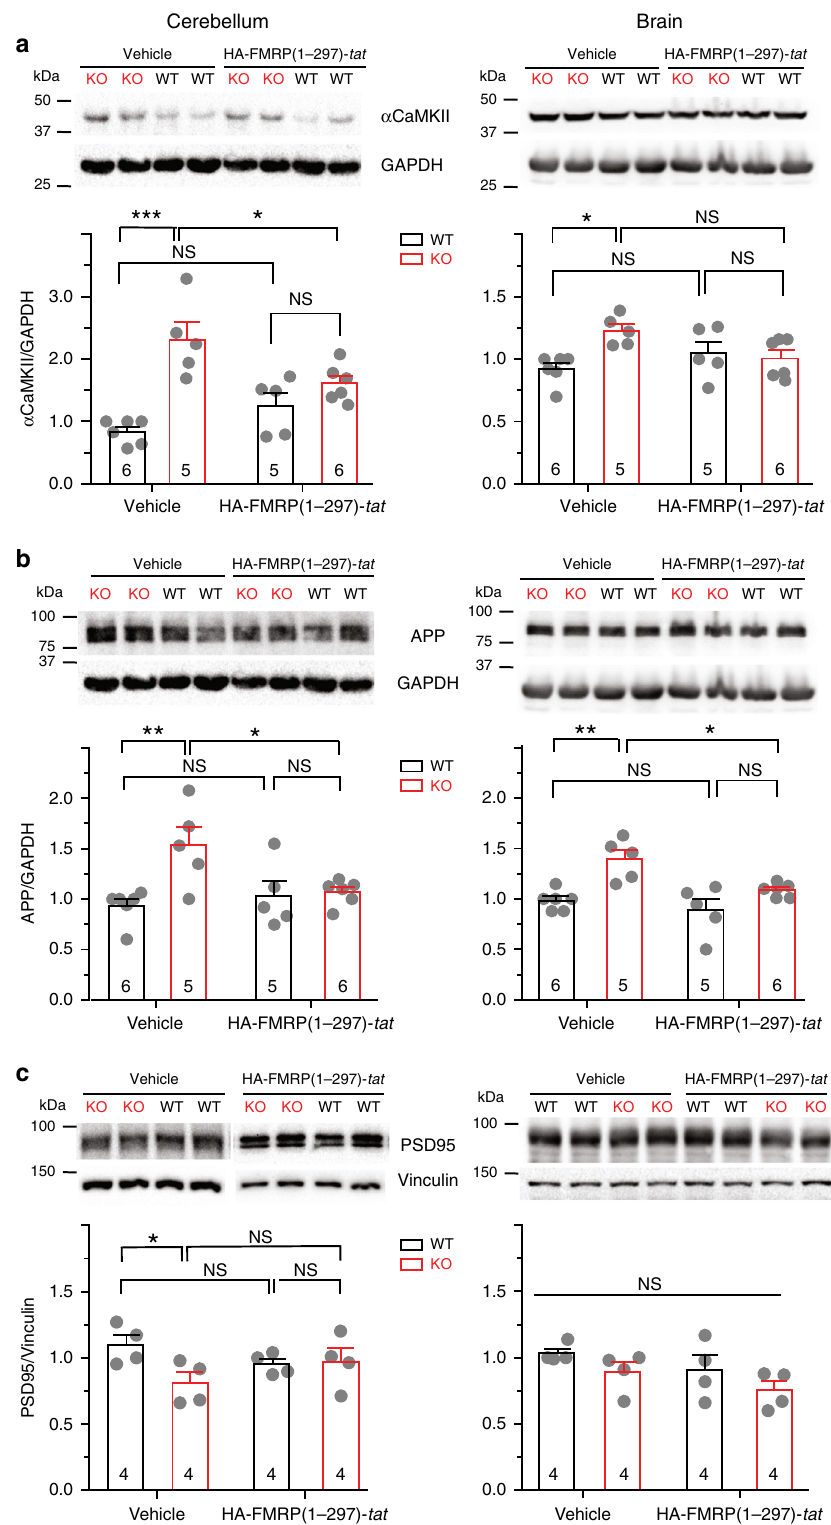
pClamp 10.5 software and digitized at 40kHz. Glass pipettes of 1.5mm O.D. (A-M Systems) pulled using a P-95 puller (Sutter Instruments) had 4 – 8 M Ω resistance. For whole-cell voltage clamp recordings, series resistance was compensated to at least 70% and leak was subtracted of fl ine in pClamp 10 software. For current clamp recordings cells with lower than − 55 mV resting membrane potential were accepted, and less than 50 pA negative bias current applied to maintain a resting potential at ∼ − 80mV. Cells were allowed to equilibrate to the internal pipette solution for 3 – 5min before